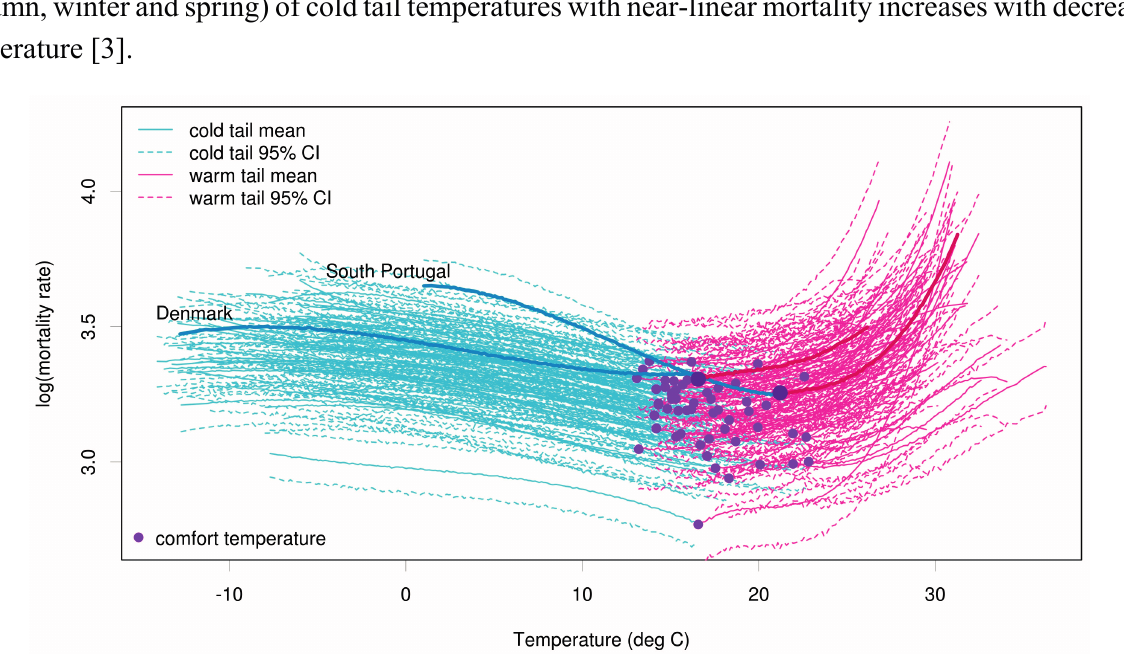
Figure 1. Posterior predictive distributions (mean and 95% credible intervals) for cold tail (blue) and warm tail (pink) estimations for all 54 regions across Europe. The comfort temperature threshold for each region is marked with a purple dot. The mean mortality curves for two contrasting regions (South Portugal and Denmark) are